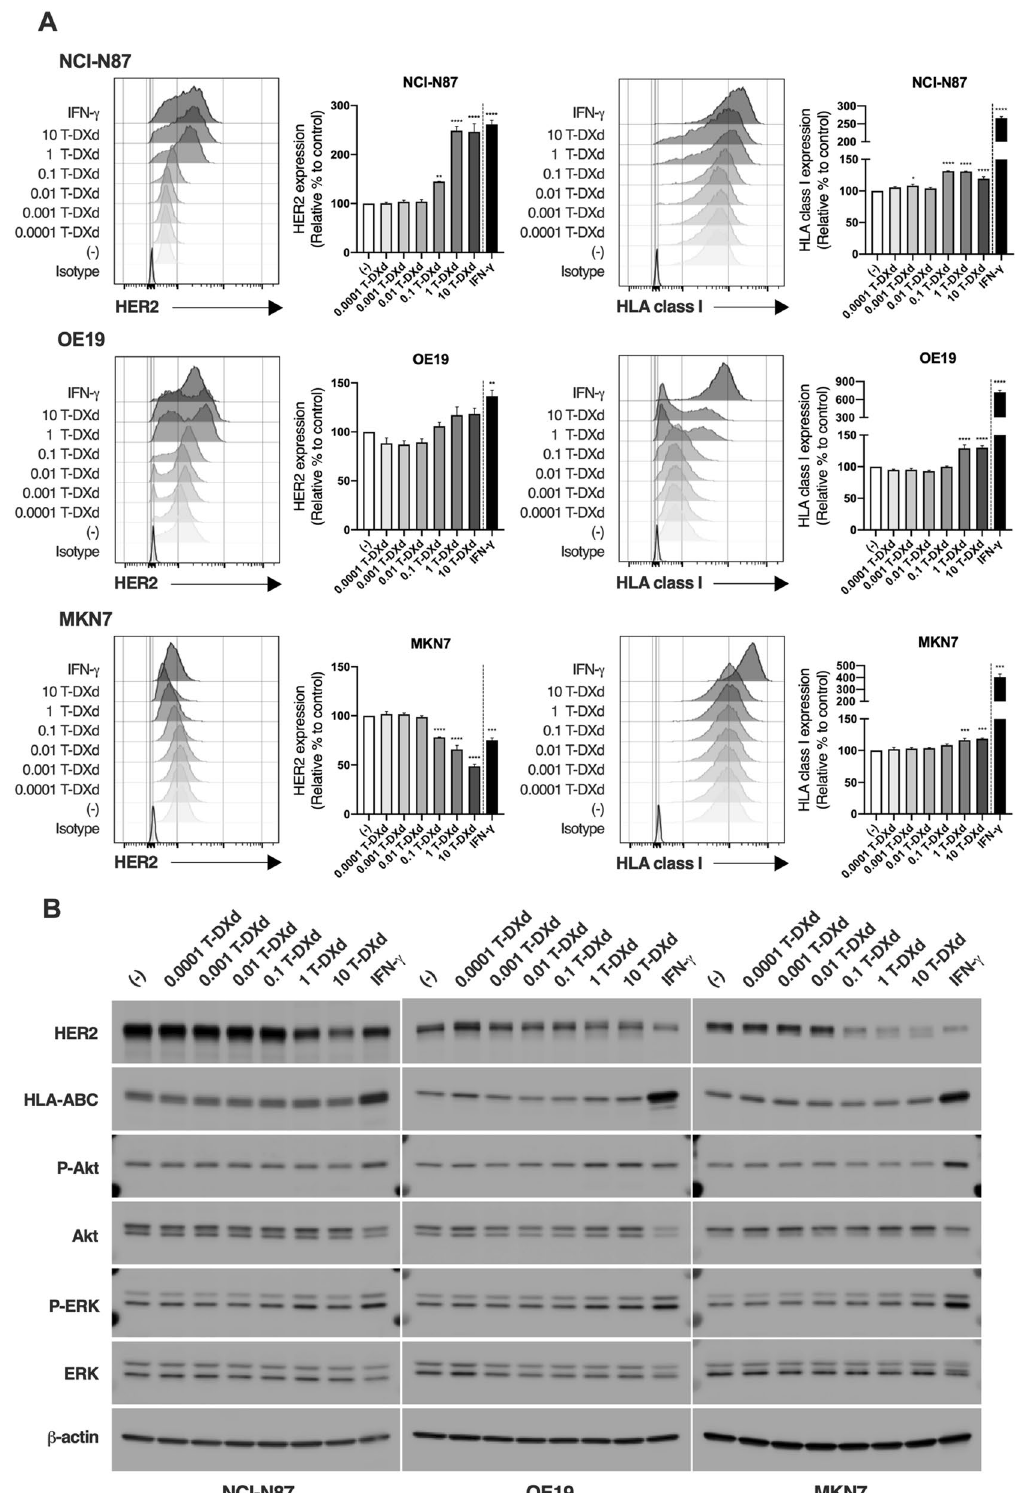
Figure 2. The effect of T-DXd on the expression of HLA class I in HER2-positive GC cells. ( A ) The expression of HER2 (left) and HLA class I (right) in HER2-positive GC cell lines treated with several concentrations of T-DXd or 100 ng/ml IFN-γ for 72 h (n = 3). Representative histograms were shown. Values are shown as means ± SEM. * P < 0.05, ** P < 0.01, *** P < 0.001, **** P < 0.0001. ( B ) Western blot analysis of the indicated molecules in HER2-positive GC cell lines treated with several concentrations of T-DXd for 72